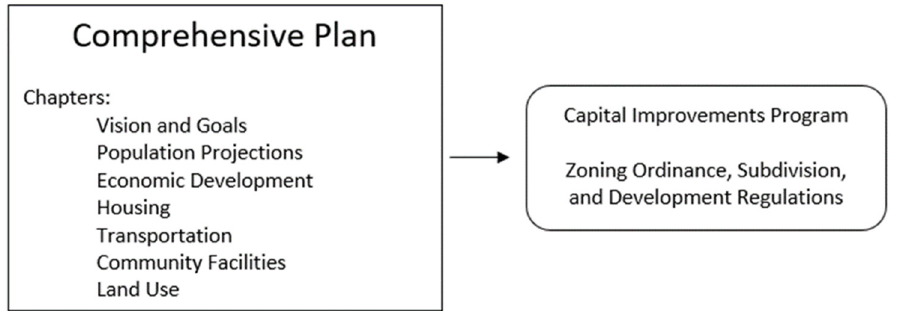
Figure 1. The traditional comprehensive plan model.